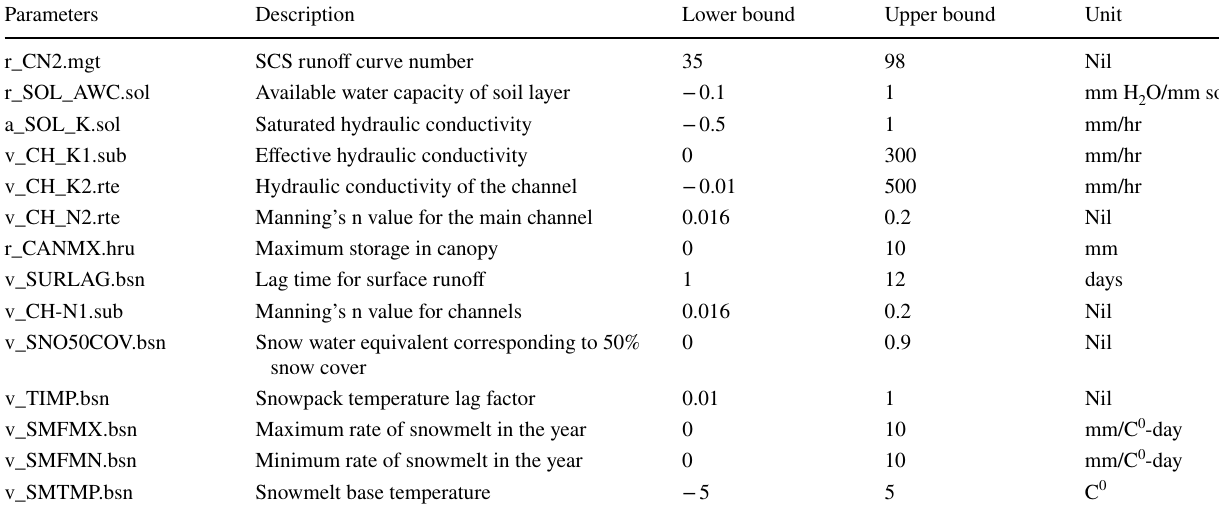
Table 2 List of sensitive parameters, their description, lower and upper bounds and units. “ a ,” “ v ,” and “ r ” represent an absolute increase to default values of selected parameters, replacing the actual